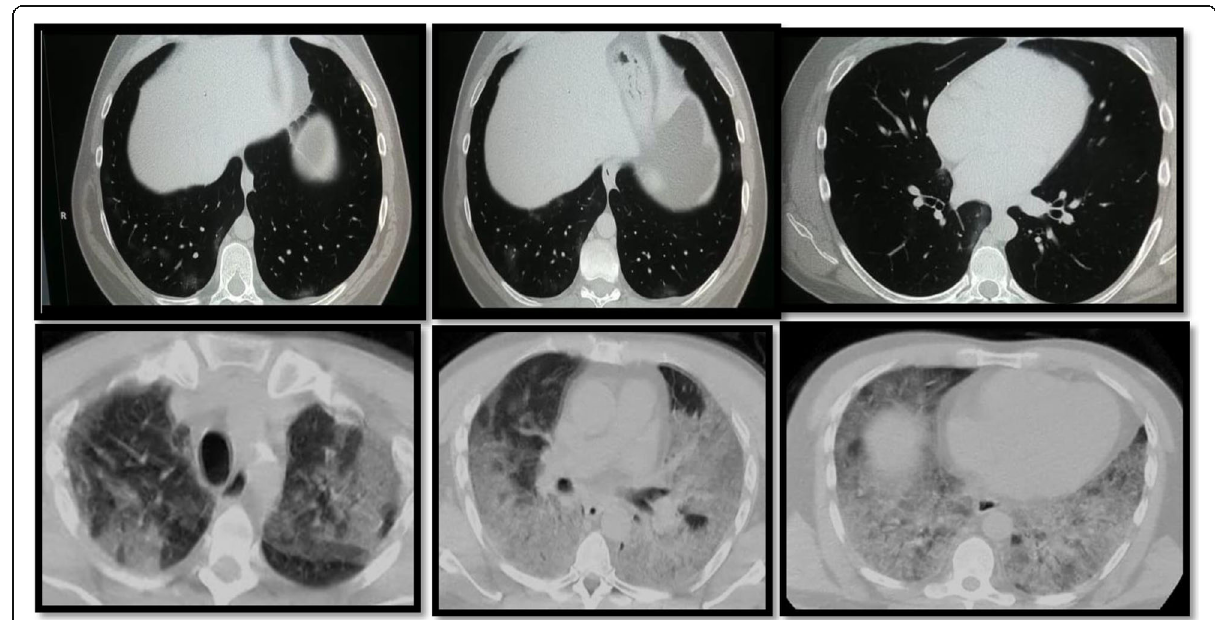
Fig. 2 A male patient, 53 years old, presented with dyspnea. MSCT chest lung window was done showing bilateral few faint mainly basal ground-glass nodular peripheral shadows. Two days later, the patient deteriorated clinically suffering severe dyspnea and fever. A follow-up MSCT chest was done showing bilateral diffuse ground glass and consolidative patches in both lung fields